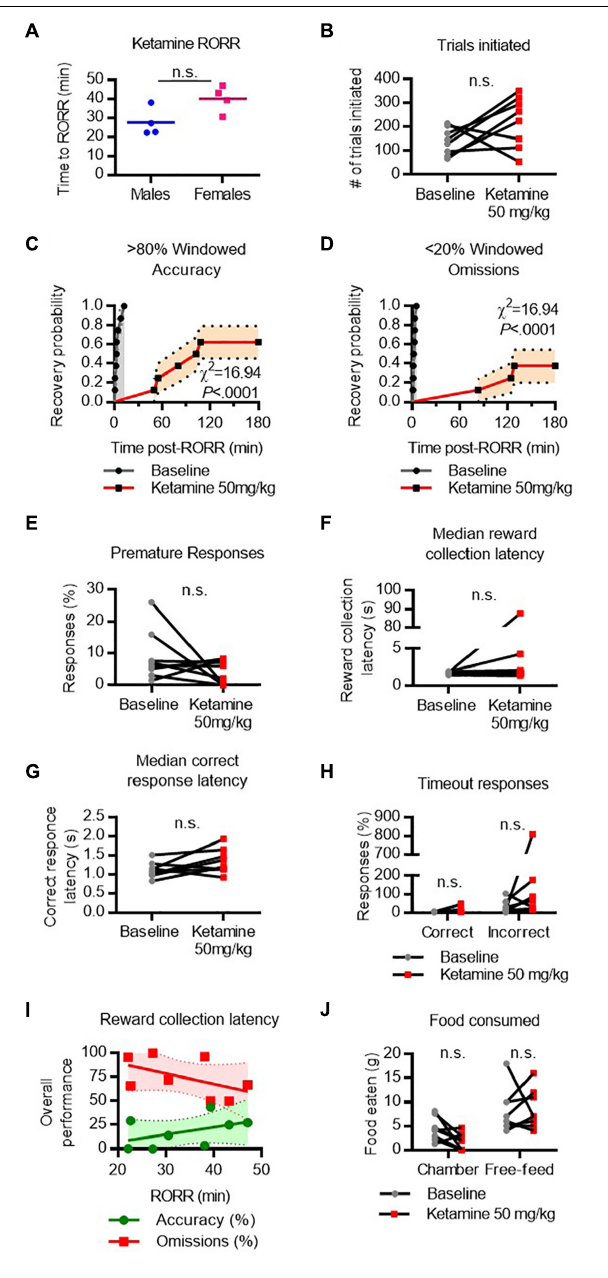
FIGURE 6 | Performance on the 5-CSRTT following ketamine. (A) Return of righting reflex (RORR) following 50 mg/kg ketamine (infused over 10 min, I.V.) in male and female rats. (B) Total number of 5-CSRTT trials initiated at baseline and following ketamine anesthesia. (C,D) Probability of achieving > 80% windowed accuracy (C) and < 20% windowed omissions (D) at baseline and following ketamine by the indicated time. (E–H) Difference in premature responses (E) , reward collection latency (F) , correct response latency (G) , and timeout responses to correct and incorrect windows (H) at baseline and following ketamine. (I) RORR latency vs. overall accuracy (green) and omission (red) performance following ketamine. Regression slope (solid line) and 95% confidence interval (dashed lines) indicated. (J) Total weight of food eaten in the chamber during the task and following the task during the free-feeding period at baseline and following ketamine. n.s., not significant; N = 8.